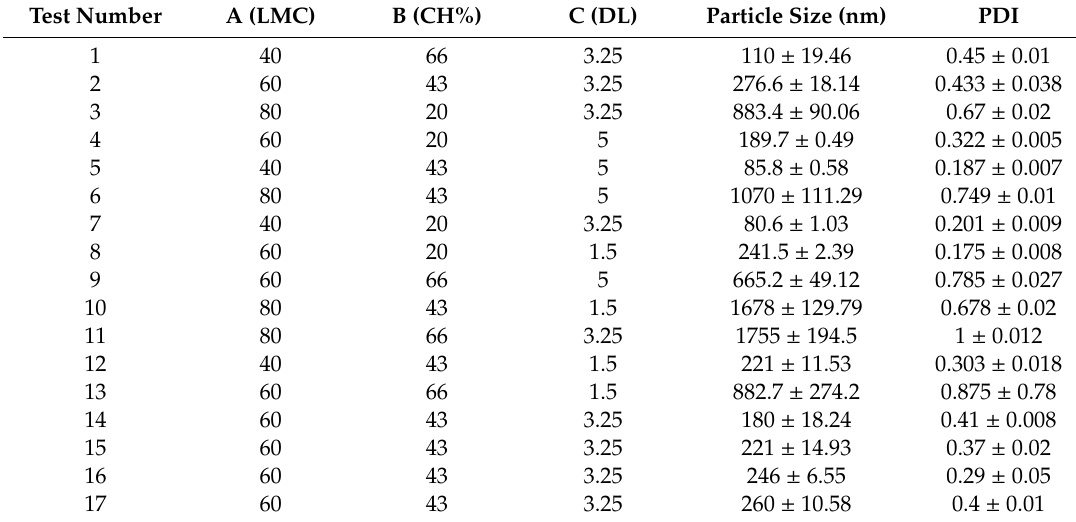
Table 2. Factors and response values for the response surface methodology (RSM) test in preparation of